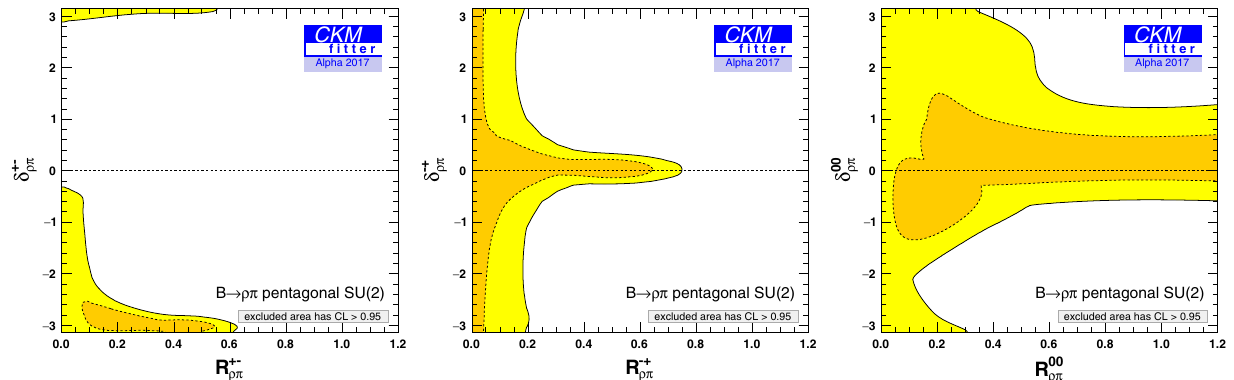
Fig. 23 68% ( dark area ) and 95% CL ( light area ) two-dimensional constraints on the modulus and phase of the penguin-to-tree ratio P ij / T ij = R ij e i δ ij for B 0 → ρ + π − ( left ), B 0 → ρ − π + ( middle ) Fig. 24 68% ( dark area ) and 95% CL ( light area ) 1D intervals on the | P ij / T ij | ratios for the different B 0 → h i h j charmless decays